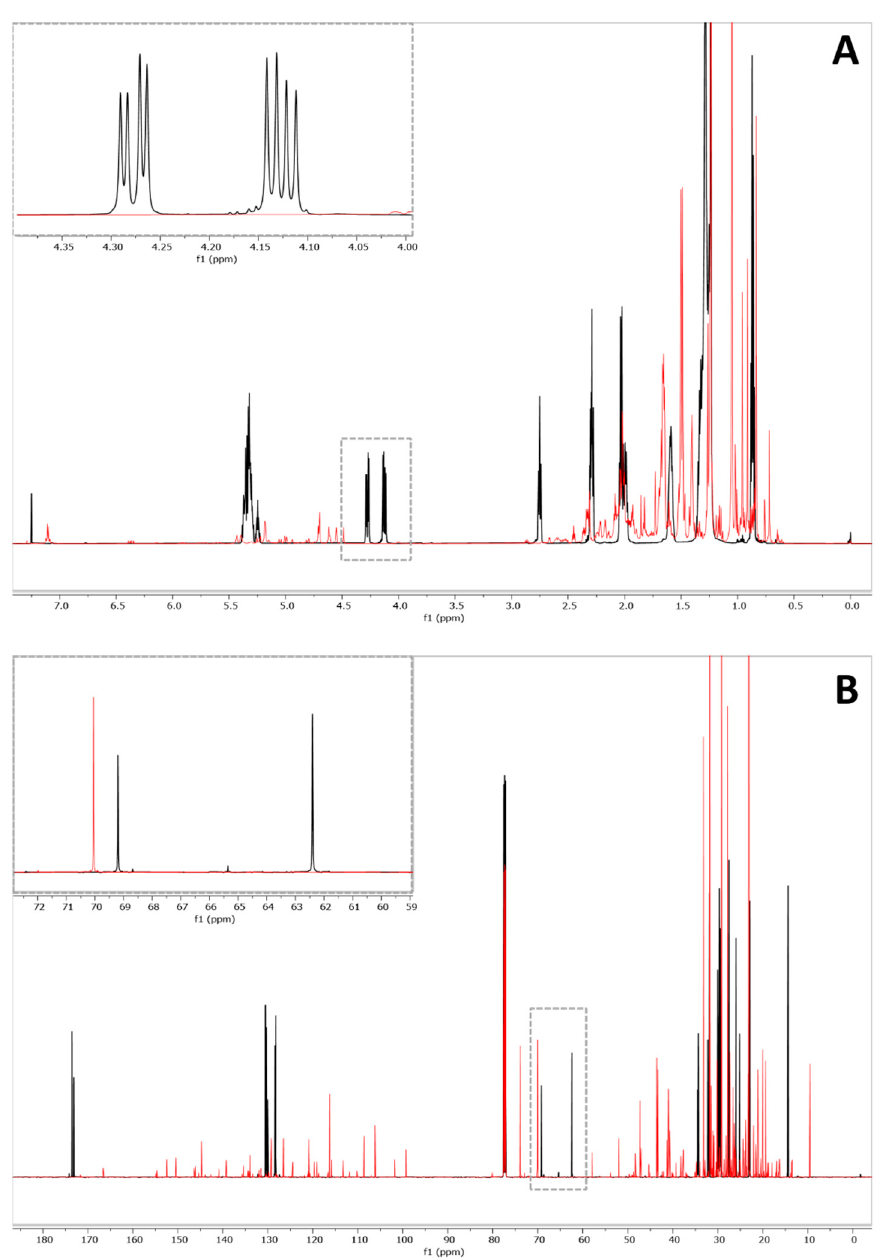
Figure 1. 1 H ( A ) and 13 C-NMR ( B ) spectra of corn oil (black) and rosemary (red). Enlargements on glycerol backbone signals.